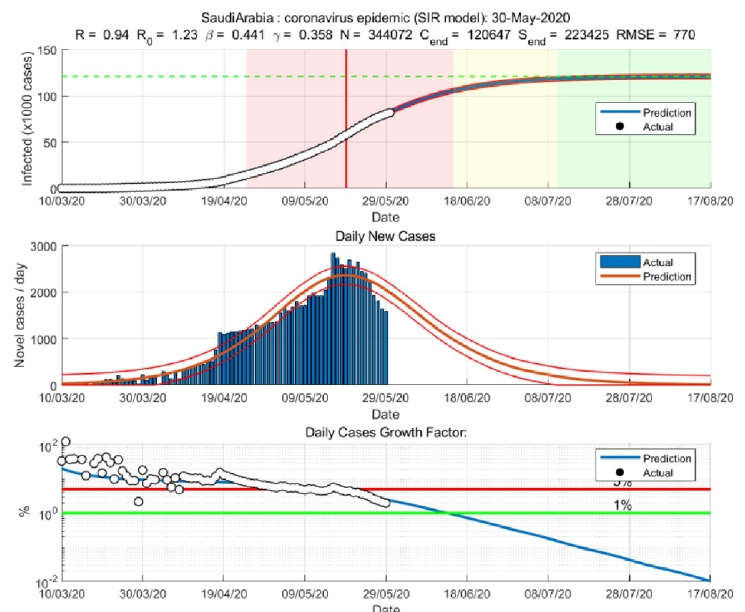
Fig 1. SIR model during lockdown period (until May 30,